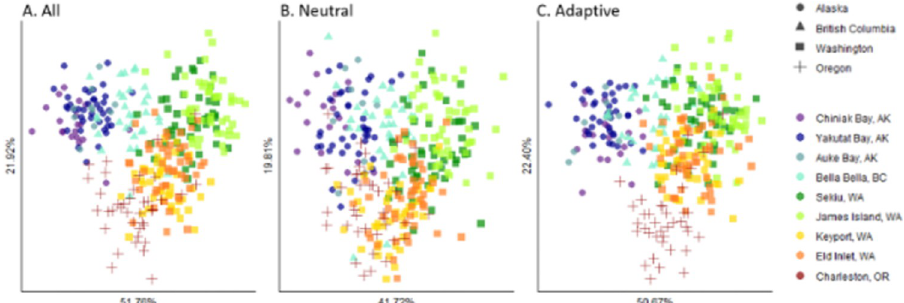
Fig 2. Discriminant analyses of principal components using all SNPs (A), putatively neutral SNPs (B), and putatively adaptive SNPs (C). Each plot represents the first two discriminant functions. For each plot, axes are labeled with the proportion of among-population variance explained by that discriminant function. Points represent individuals and are colored by collection site, matching the colors of collection sites in the map (Fig 1). Point shapes differ by state to highlight regional effects.